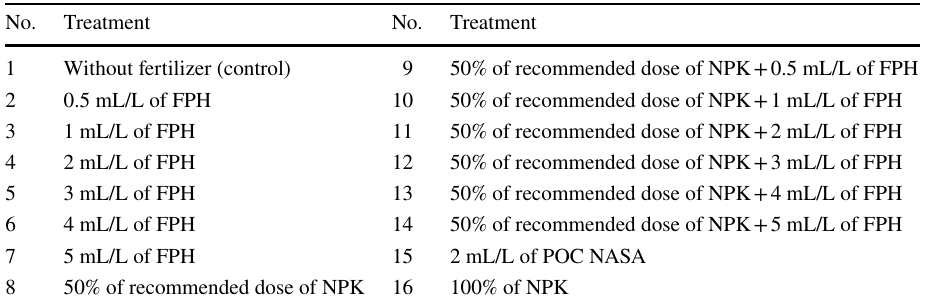
Table 3 Details of 16 treatments